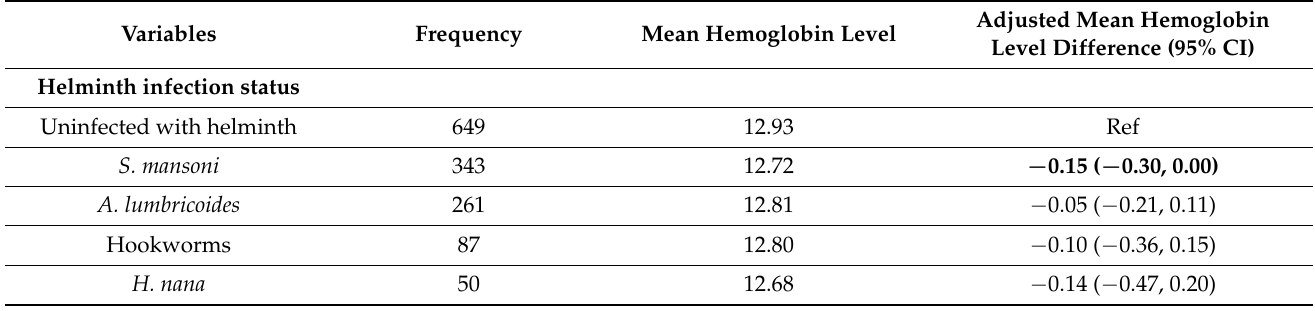
Table 2. Mean hemoglobin level difference by helminth infection status, nutritional status, age group, and gender among school children in Maksegnit from May to July 2021 (N =